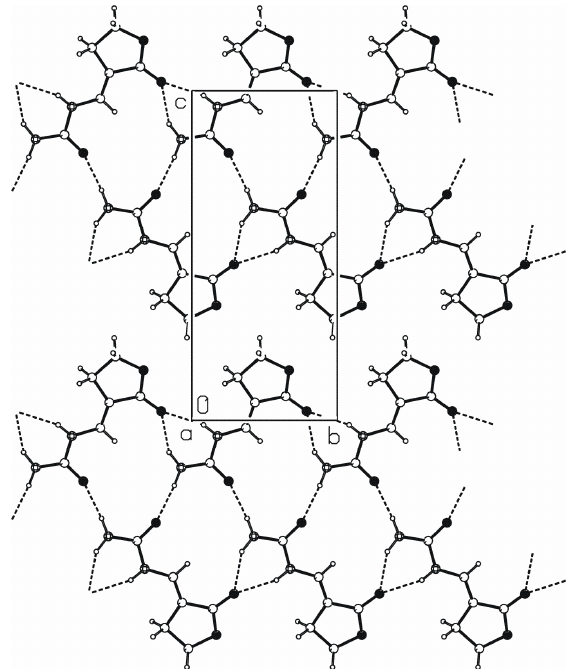
Figure 4 . A crystal packing diagram of 2 , viewed along the b axis, showing parallel chains of hydrogen-bonding